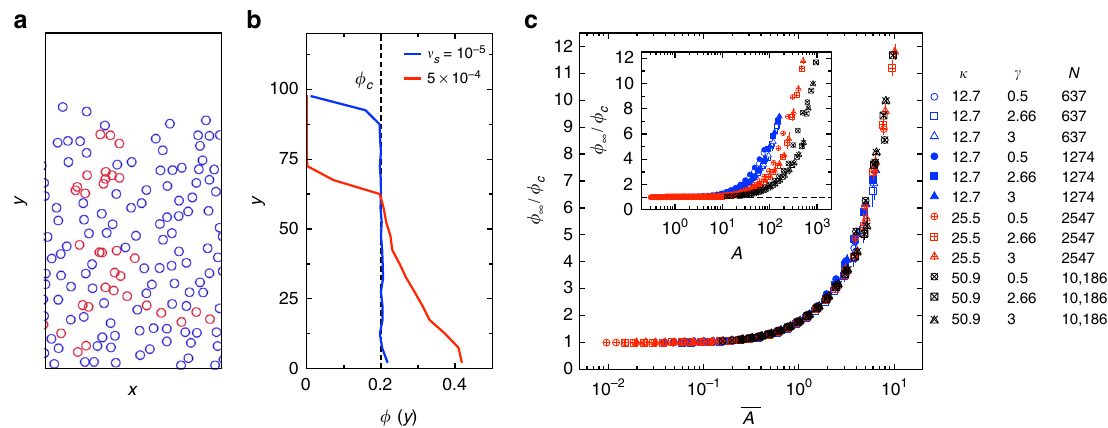
Fig. 2 Self-organized criticality at low sedimentation speed. a Snapshot of a system in the steady state. Red particles are colliding in the current cycle. b Particle concentration (plotted on the x axis) versus vertical coordinate, y , at low and high sedimentation velocity v s , with N = 2547, γ = 3.0, κ = 25.5, and L = 100. Vertical dashed line shows ϕ c ( γ = 3) = 0.20. c Scaled steady state concentration ϕ ∞ / ϕ c , measured over a wide range of system parameters ( κ , γ , and N as shown in legend) and velocities (10 − 5 < v s < 10 − 2 ). Inset: Measurements versus the parameter A = ( π / ϕ c ) 3/2 d 3 κ 2 v s /32 D , proposed by ref. 16 . The data is not collapsed. Main: The data collapses when replotted versus A (Eq. (1)). For A (cid:1) 1 (low sedimentation speed), the steady state concentration ϕ ∞ is equal to the critical value ϕ c . Error bars show the size of fl uctuations within the steady state